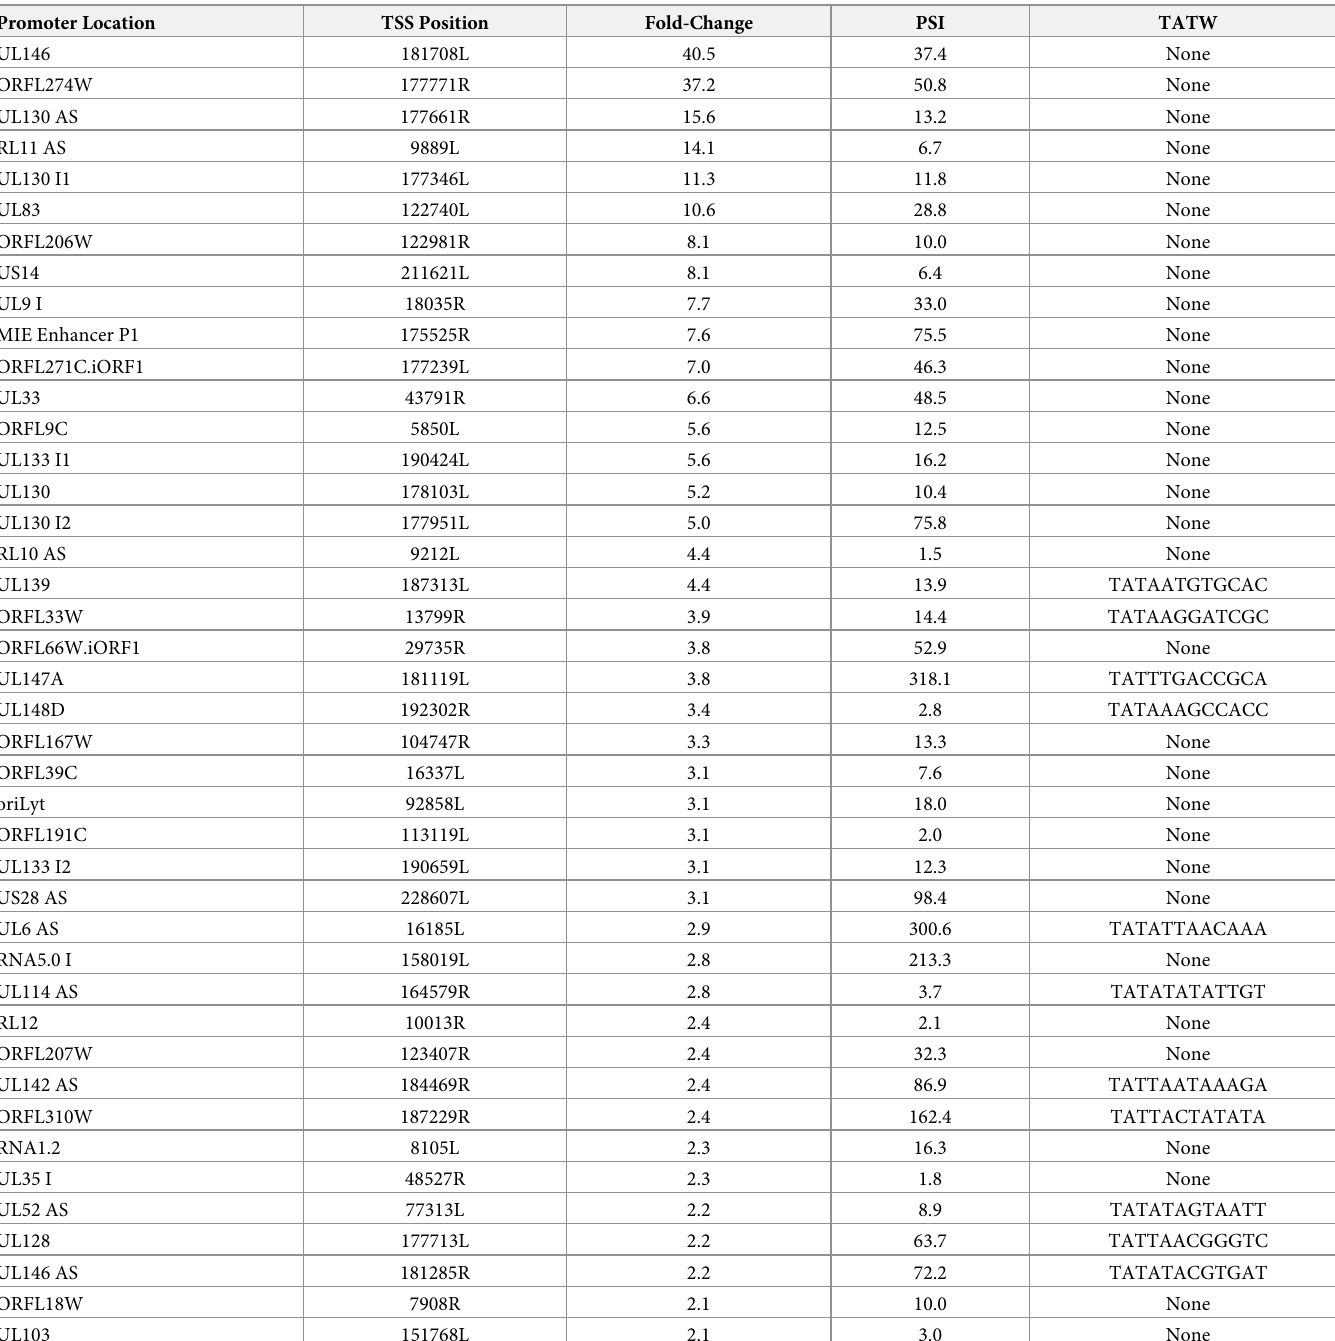
Table 1. IE2-activated HCMV transcription start